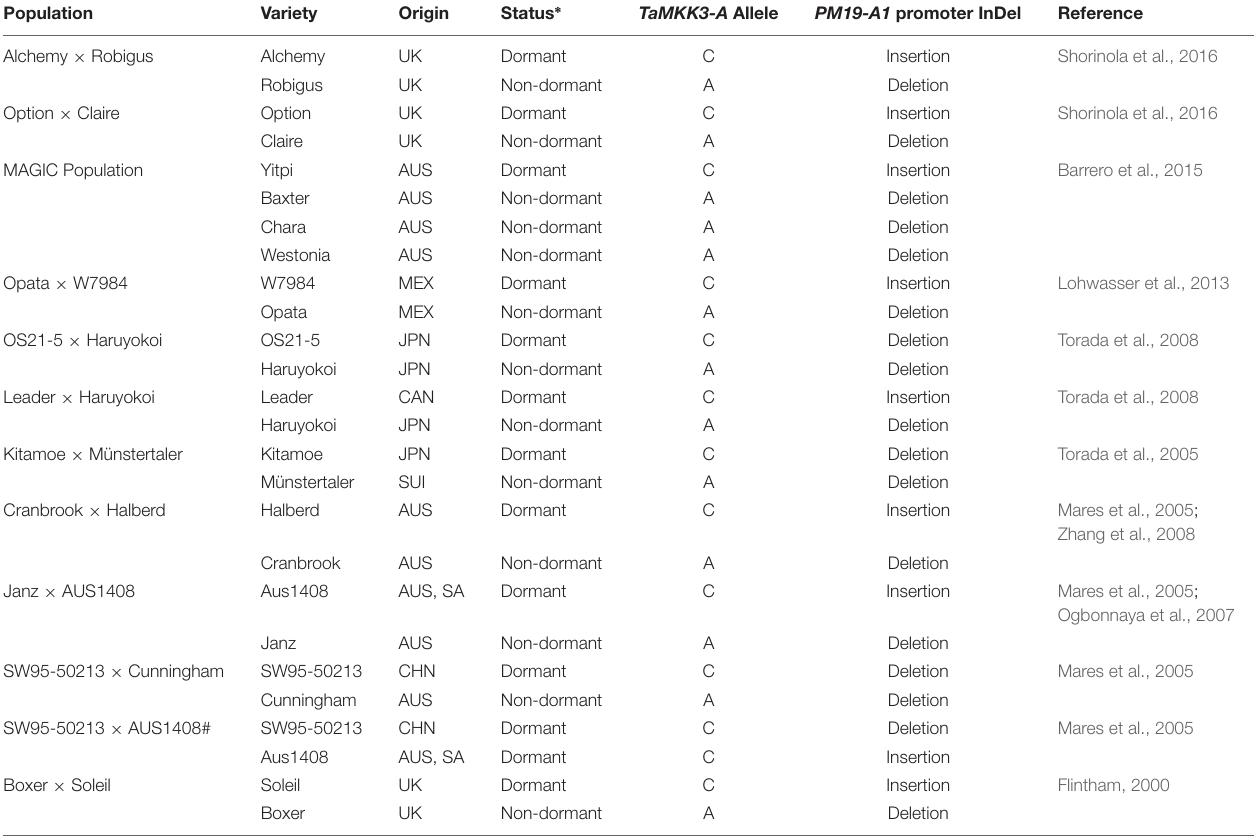
TABLE 1 | TaMKK3-A and PM19 alleles in Phs-A1 association